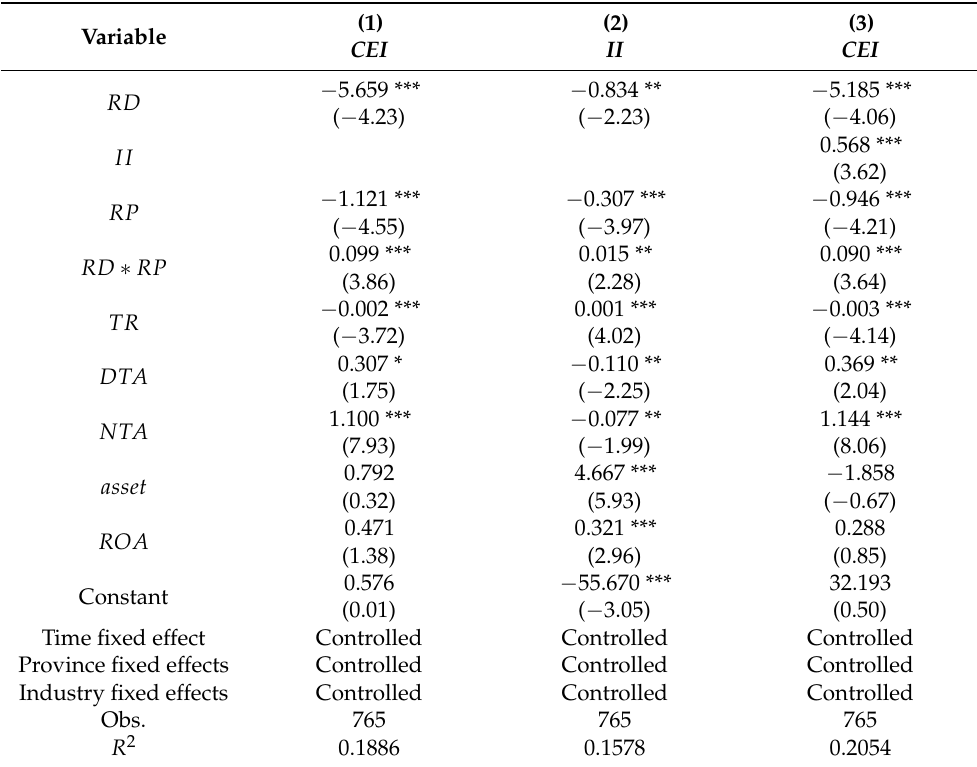
Table 10. Regression results of the mediated moderating